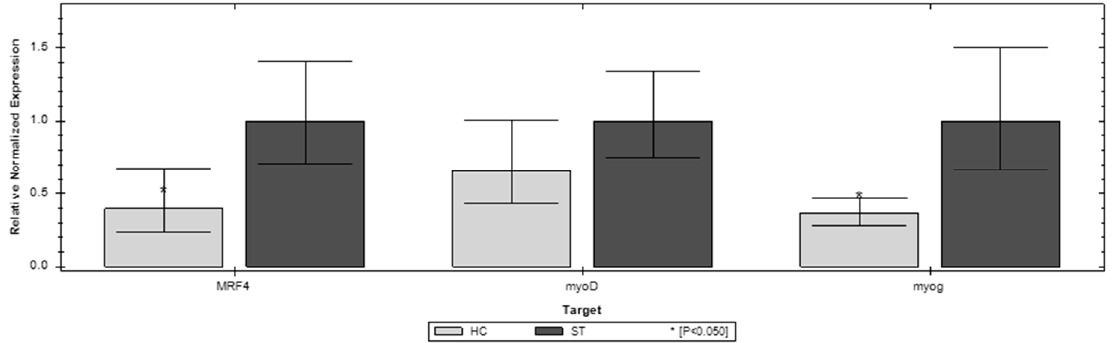
Figure 2. Relative expression of the MFR4, myoD, and myoG genes on the first day (D1) of life in the standard (ST) and HatchCare (HC) groups ( p = 0.049 for MRF4, p = 0.508 for myoD, and p = 0.048 for myog). Significant difference compared to ST (* p < 0.05). The figure was generated with CFX Maestro Software 2.3.